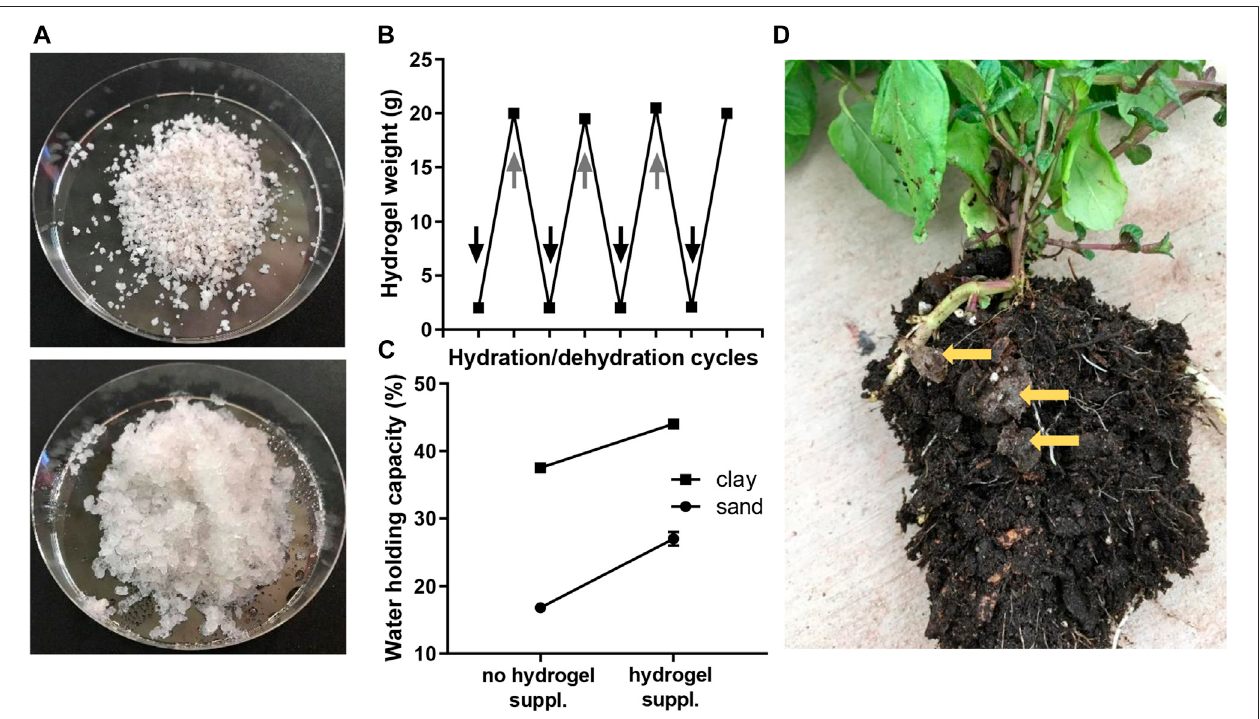
FIGURE 1 | Water holding and release properties of hydrogels (A) Sample of 1 g of dry hydrogel (left) , and saturated with water and incubated 10 min (right) (B) Hydrogel weight during hydration/dehydration cycles. A sample of 2 g of dry hydrogel was saturated with water (hydration; black arrows), incubated 10 min at room temperature prior to weighing, and dried on absorbing paper at room temperature for 24 h (dehydration; gray arrows) (C) ) Water holding capacity of sand and clay soils with (hydrogel suppl.) or without (no hydrogel suppl.) 0.1% (w/w) hydrogel supplementation (D) Hydrogels (arrows) fi xed on spearmint ( Mentha spicata )